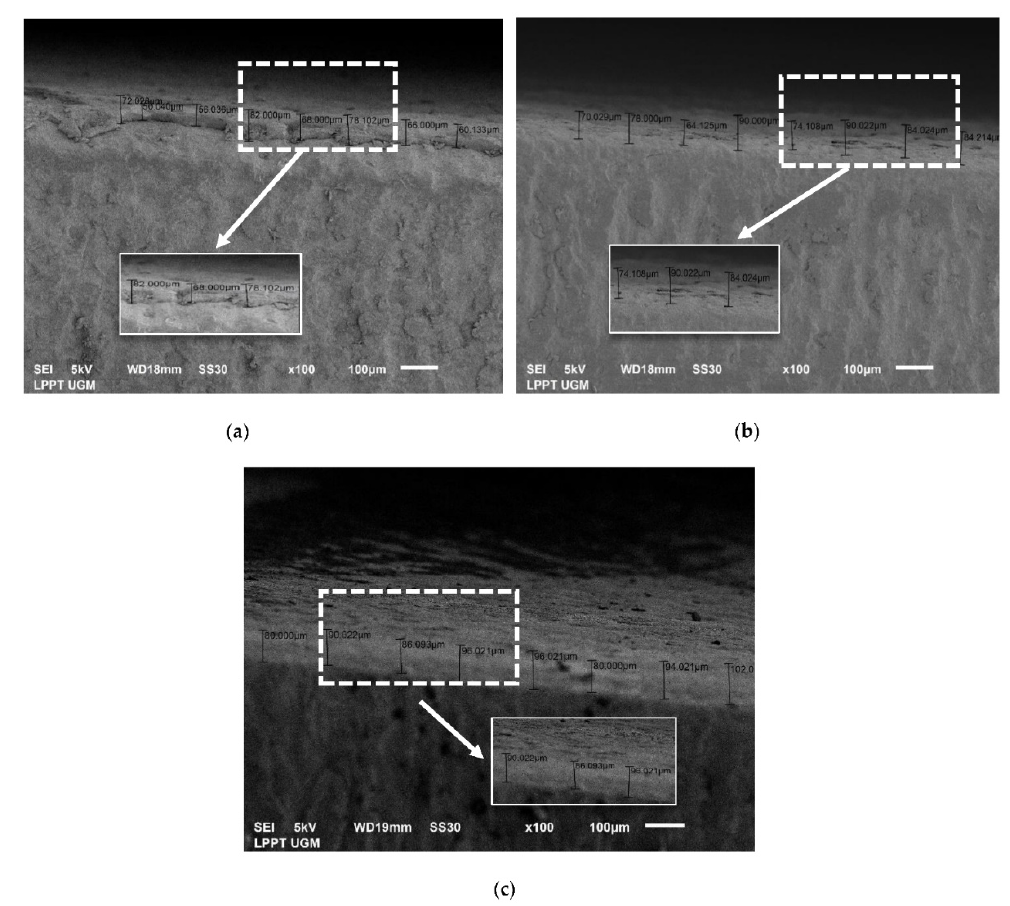
Figure 10. Cross-section of CHA/HCB/Ti coating with immersion times variation of: ( a ) 10 min; ( b ) 20 min; ( c ) 30 min (the white arrow indicates a cross-section of the CHA/HCB/Ti coating). Table 6. Average thickness value of CHA/Ti and CHA/HCB/Ti coatings.